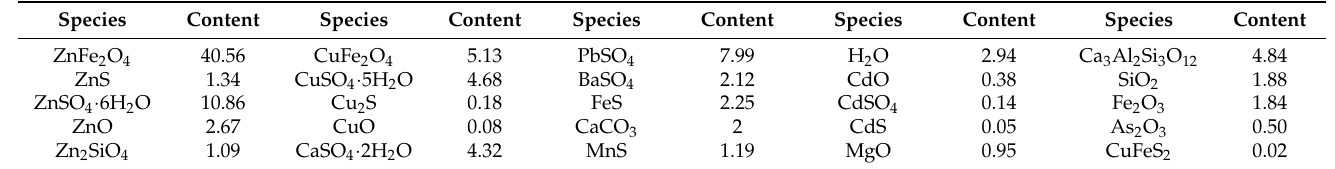
Table 1. Model composition of the ZPR sample for thermodynamic calculation, wt. %. Species Content